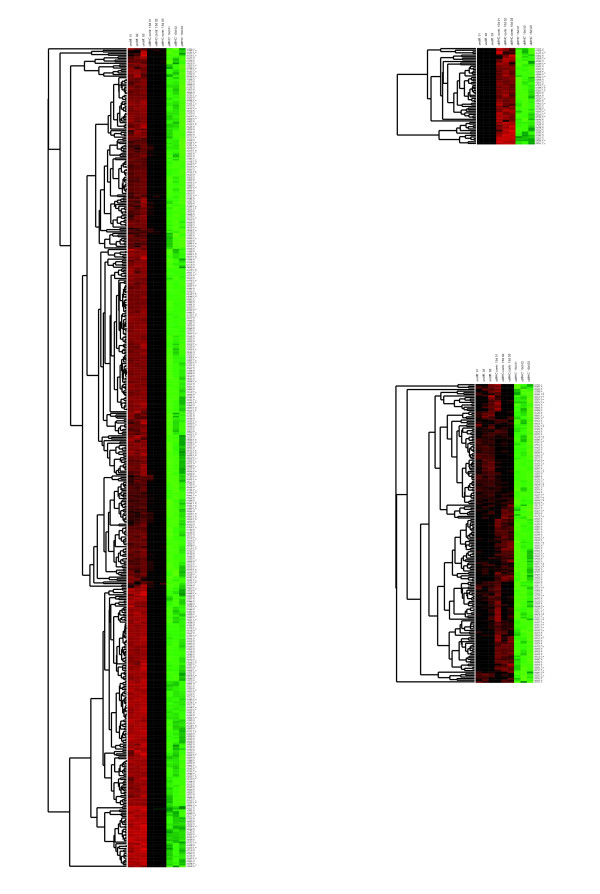
Hierarchical clustering of probe sets identified as downregulated in α-MHC+ cells. Shown is a visualization of the hierarchical clustering of probe sets identified as downregulated in the α-MHC+ cells with an expression level at least twofold lower than in 15-day-old EBs and in α-MHC embryonic stem cells. Each probe set is represented by a single row of colored boxes; each array is represented by a single column. Rectangles corresponding to intermediately expressed probe sets are colored black, upregulated probe sets are indicated with red of increasing intensity, and weakly expressed probe sets with green of increasing intensity. The dendrogram on the left of the figure represents the similarity matrix of probe sets.